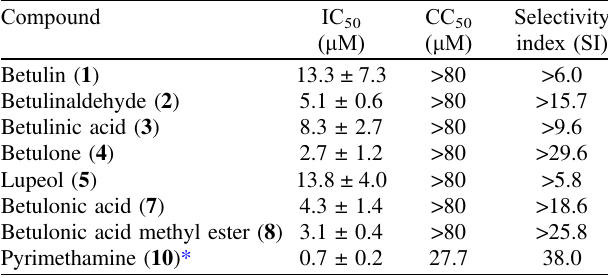
Figure 1. 2D representation of puri fi ed compounds ( 1 – 6 , 9 ) from n -heptane extract of A. glutinosa bark, commercially available compounds ( 7 , 8 ), and reference antiparasitic compound ( 10 ). Table 2. In vitro determination of IC 50 , CC 50, and SI from puri fi ed and commercial lupane-type triterpenes on T. gondii .